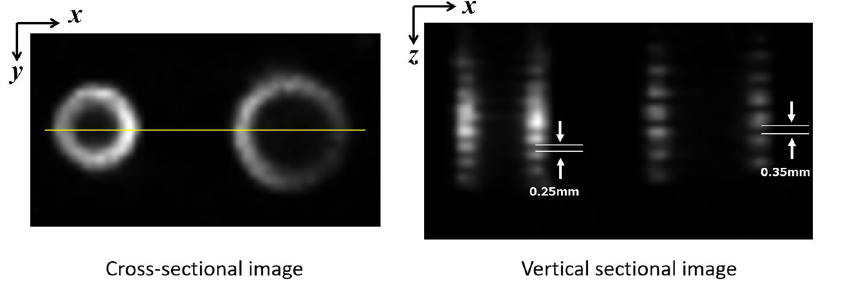
Figure 17. Horizontal and vertical sectional images of Phantom